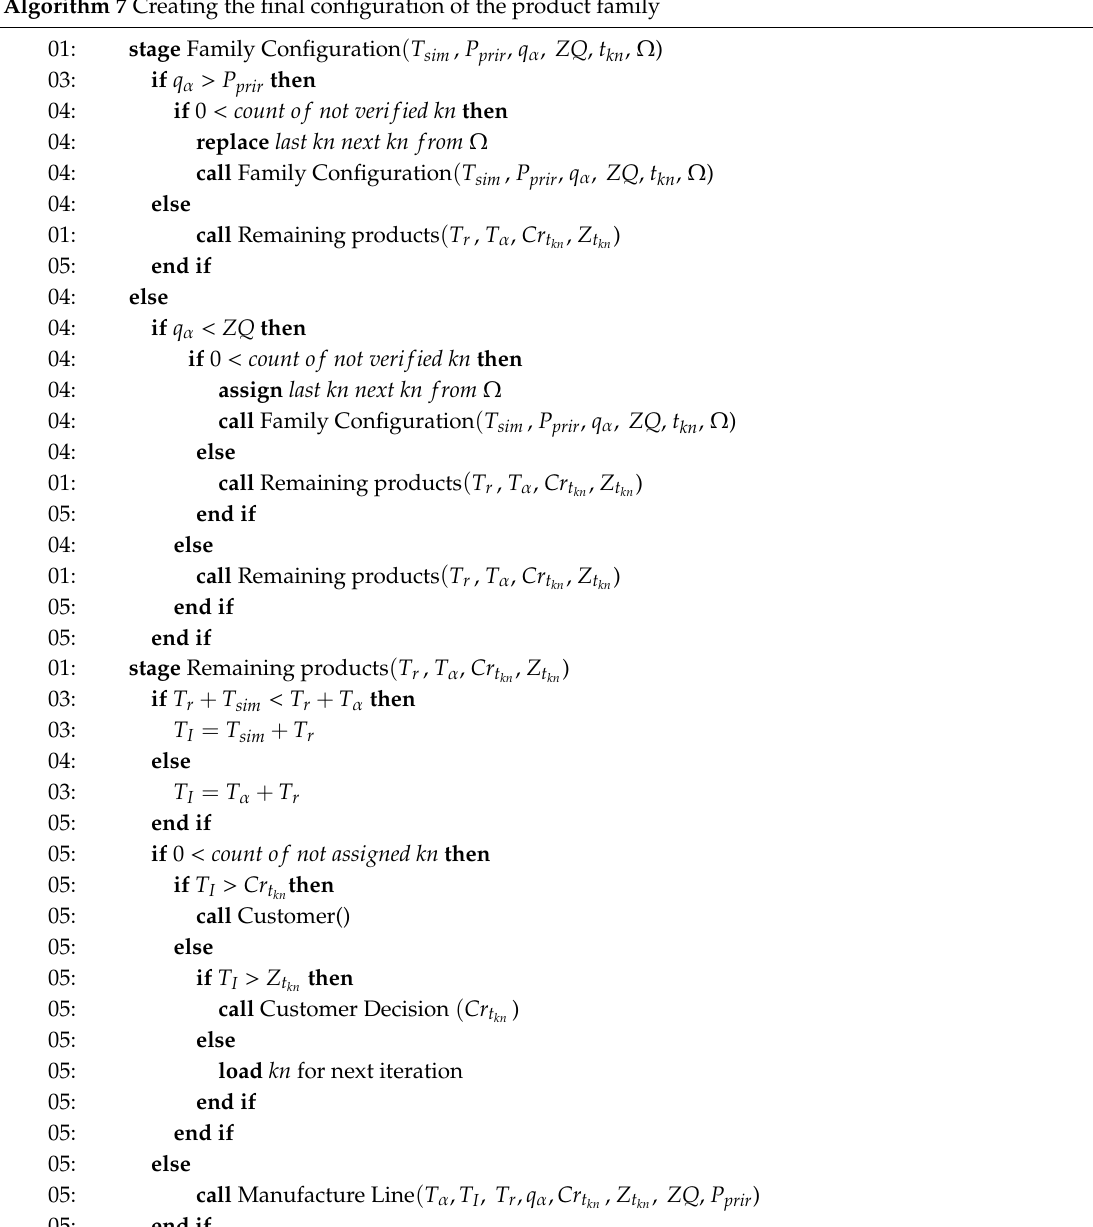
Algorithm 7 Creating the final configuration of the product